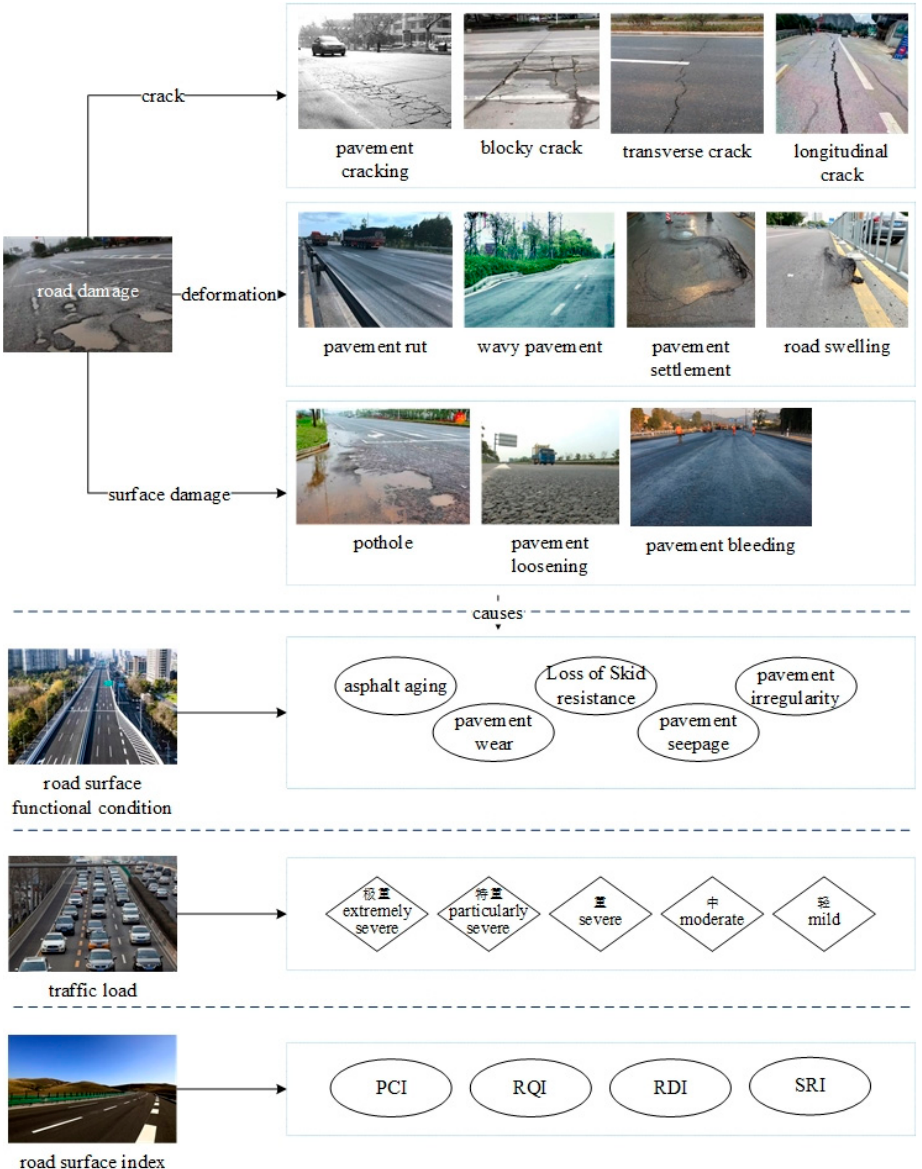
Figure 2. Road-related concepts and indexes extracted from the standards. Figure 2. Road‑related concepts and indexes extracted from the